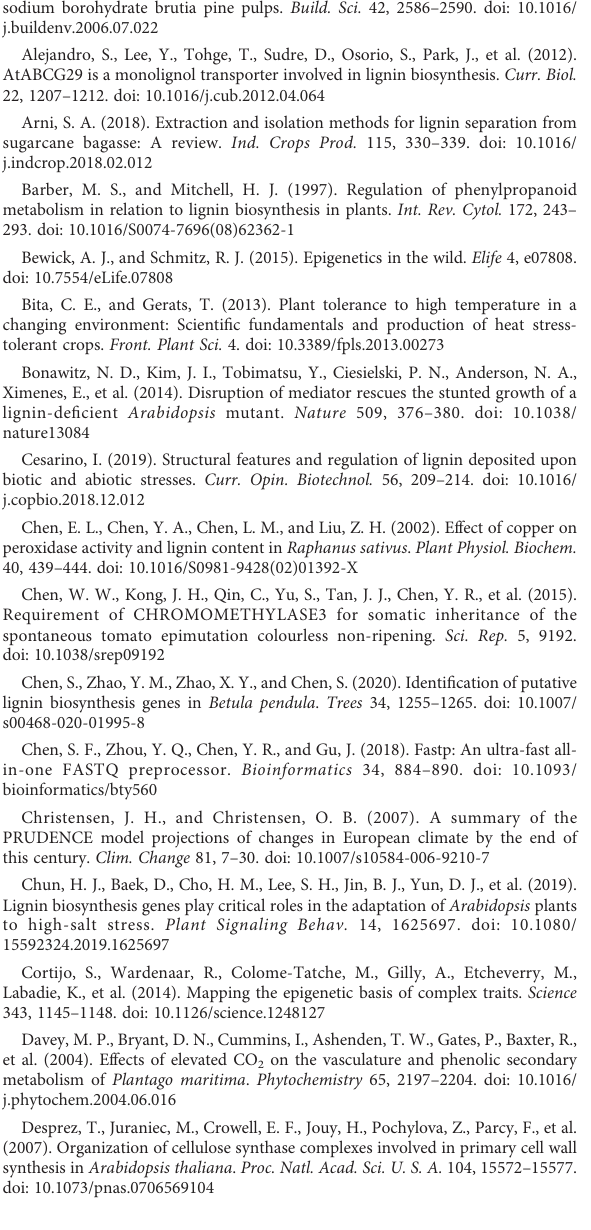
Ame, and Alh. Box in grey color indicate regions with pronounced methylation variations in their promoter region. SUPPLEMENTARY FIGURE 12 Transcript level of BpCesA s in birch. (A) Phylogenetic analysis of CesAs of birch and Arabidopsis . The rooted neighbor-joining (NJ) phylogenetic tree of CesAs wasclustered withbootstrap values shown for each clade in circles with a different size. The CesA s of Arabidopsis with green star outside function mainly in second plant cell wall, and those with blue star outsidefunctionmainlyinprimaryplantcellwall. “ ? ” indicates thefunction of the gene is remain unclear. (B) Transcript level of BpCesA s in Sl, Fhs,